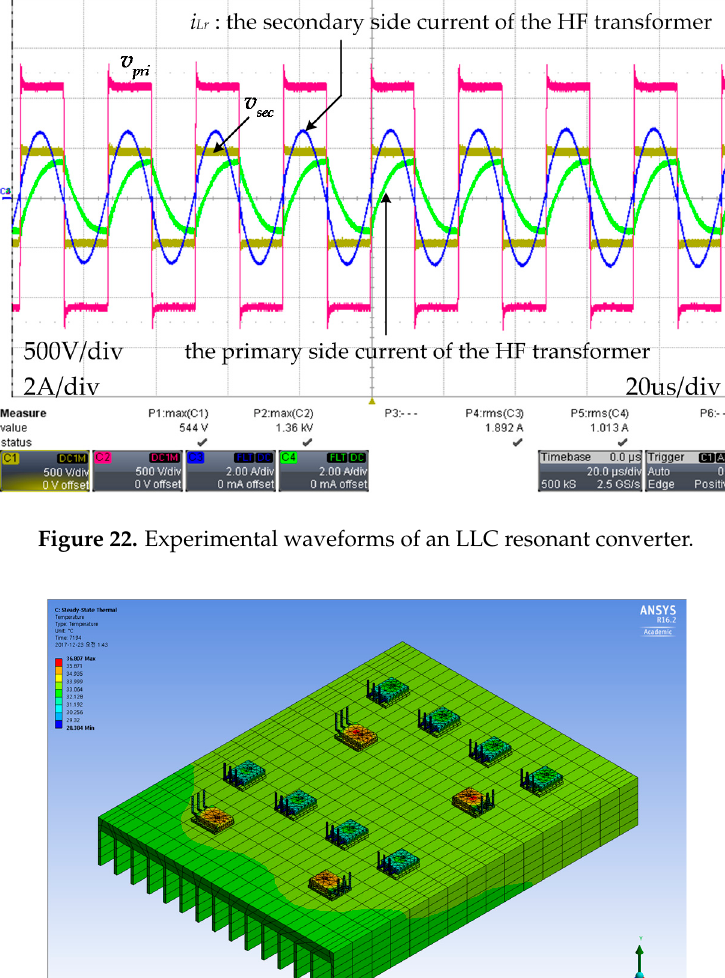
Figure 21. The switching voltage and the input current of the AFE converter cascaded in 10 modules with the proposed offset compensation algorithm.